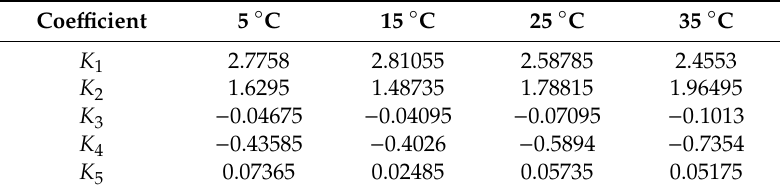
Table 3. Coe ffi cient values at di ff erent ambient